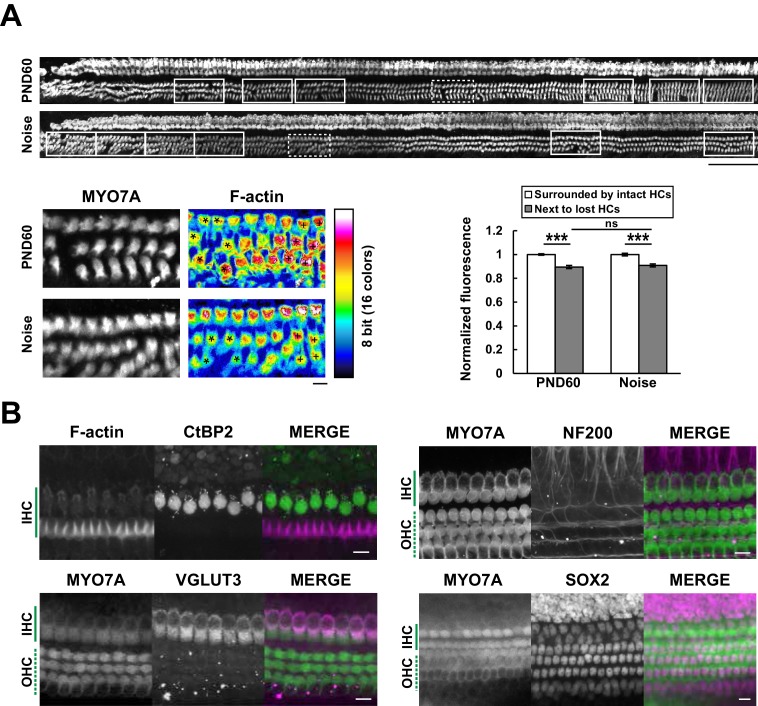
Efficient mapping of subcellular pathology and multiple cellular components.(A) Automated detection of areas with variable degrees of hair cell loss, combined with evaluation of subcellular pathology. All sites of hair cell loss (white squares) were selected, and changes in the F-actin content were evaluated (upper image). White squares with dotted lines are representative analysis areas, and are enlarged at lower left. Hair cells surrounded by intact hair cells (crosses) or next to lost cells (asterisks) were compared for their F-actin content (lower right). The graph reveals loss of F-actin in hair cells adjacent to lost cells. Scale bars, 100 μm (upper) and 10 μm (lower). [n = 108 (PND 60) and 103 (Noise), paired t-test for comparison within the group, Welch’s t-test with Bonferroni’s correction for comparison of cell groups between different experimental conditions, ***p < 0.001; ns, not significant, p > 0.05.] (B) Modified ScaleS technique can be adapted to multiple immunohistochemistry of cellular and subcellular components at PND 5. Antibodies against CtBP2, VGLUT3, NF200, and SOX2 were used to detect multiple components in situ. Scale bars, 10 μm. HC, hair cell; IHC, inner hair cell; OHC, outer hair cell; PND, postnatal day.10.7554/eLife.40946.020Figure 5—source data 1.Source data for Figure 5A.